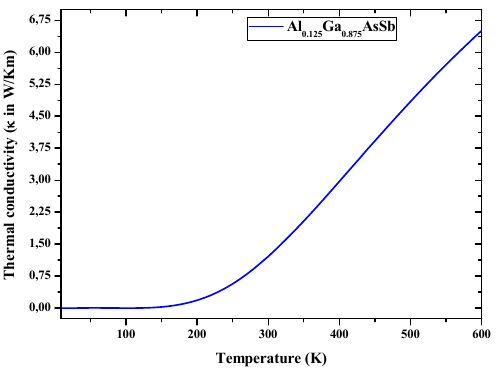
Figure 7. Thermal conductivity ( κ ) of the Al 0.125 Ga 0.875 Sb 0.75 As 0.25 nanostructured material.